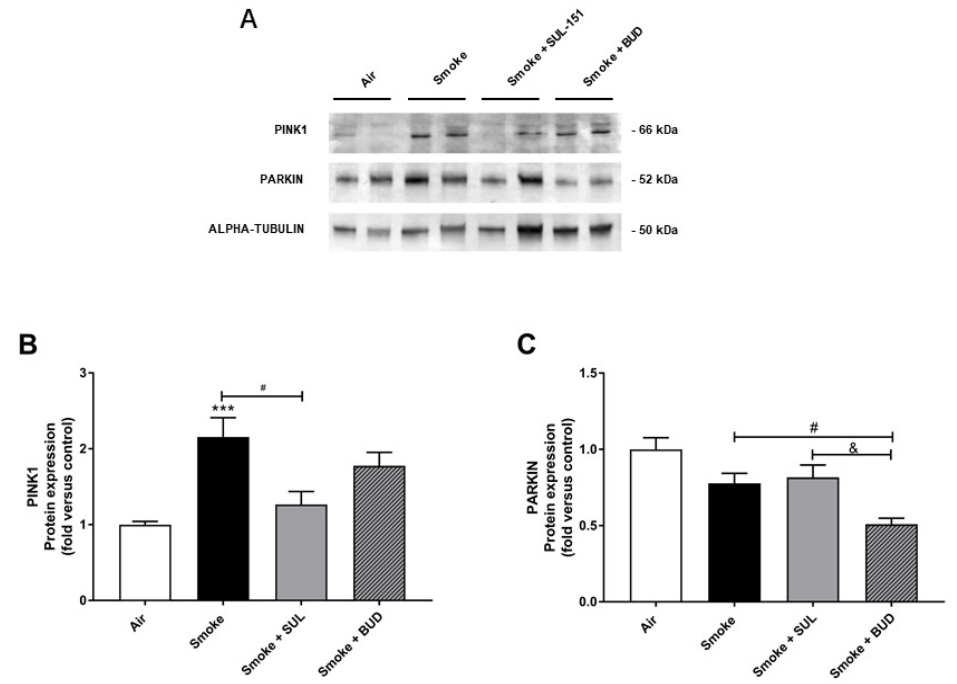
Figure 6. SUL-151 inhibited the increase in PINK1-expression in the lungs after the development of CS-induced pulmonary inflammation. Mice were exposed to CS for 10 days (twice/day) and received SUL-151 or budesonide via oropharyngeal administration (once/day) 30 min before the first smoke exposure during the last 5 days of the CS period. Western blot analysis for protein levels of PINK1, Parkin, and α -tubulin ( A ) was measured in the lung homogenates, and relative densities of the PINK1/ α -tubulin ( B ) and Parkin / α -tubulin ( C ) were calculated. Values are expressed as mean ± SEM. *** p < 0.001, smoke group compared to air group; # p < 0.05, smoke + SUL group or smoke + budesonide (BUD) group compared to smoke group; & p < 0.05, smoke + BUD group compared to smoke +SUL group. n = 6–7 mice/group.